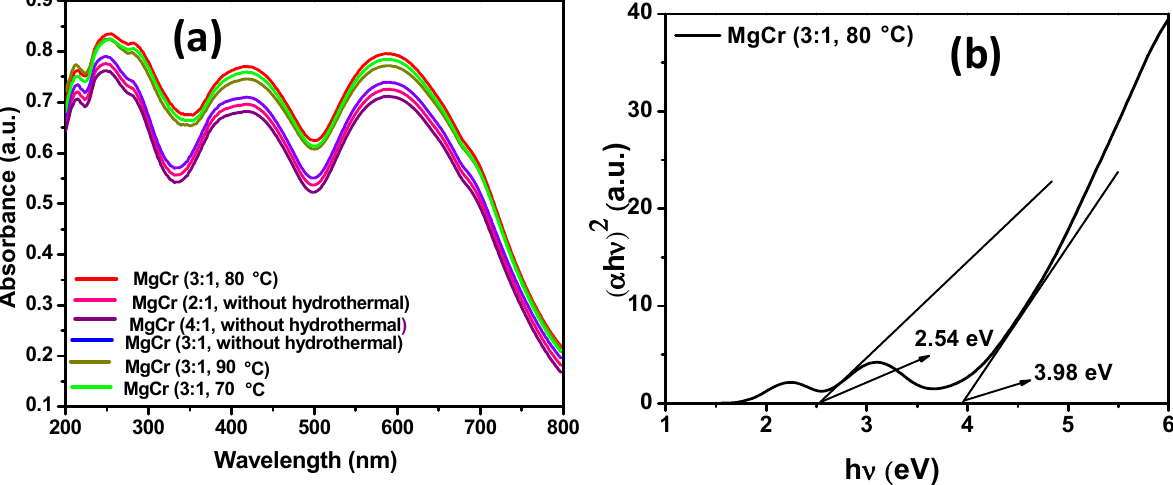
Figure 3. ( a ) UV-Vis DRS spectra of the series of exfoliated MgCr-LDH (2:1, 3:1, 4:1) without hydrothermal and MgCr-LDH (3:1) with hydrothermal treatment of 70, 80, and 90 °C. ( b ) Band gap energy of MgCr-LDH (3:1, 80 °C) as derived from Kubelka–Munk equation through Tauc plot.